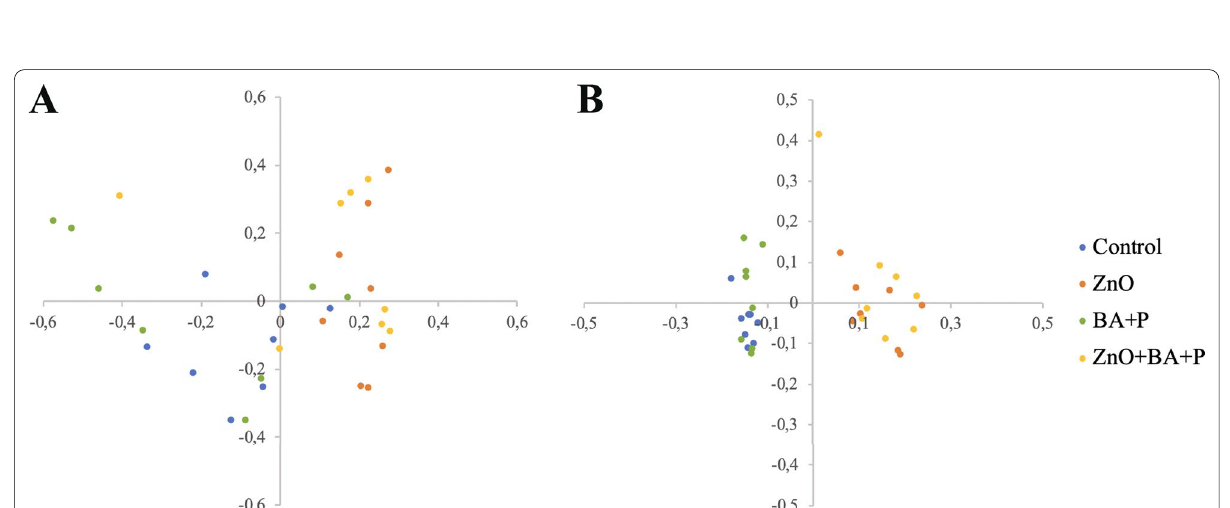
Fig. 3 Principal coordinate analysis (PCoA). PCoA comparing the similarities between bacterial community structure ( A ) and membership ( B ) present in the cecum of post-weaning piglets supplemented with Zinc Oxide (ZnO), Benzoic acid plus probiotic (BA supplementation